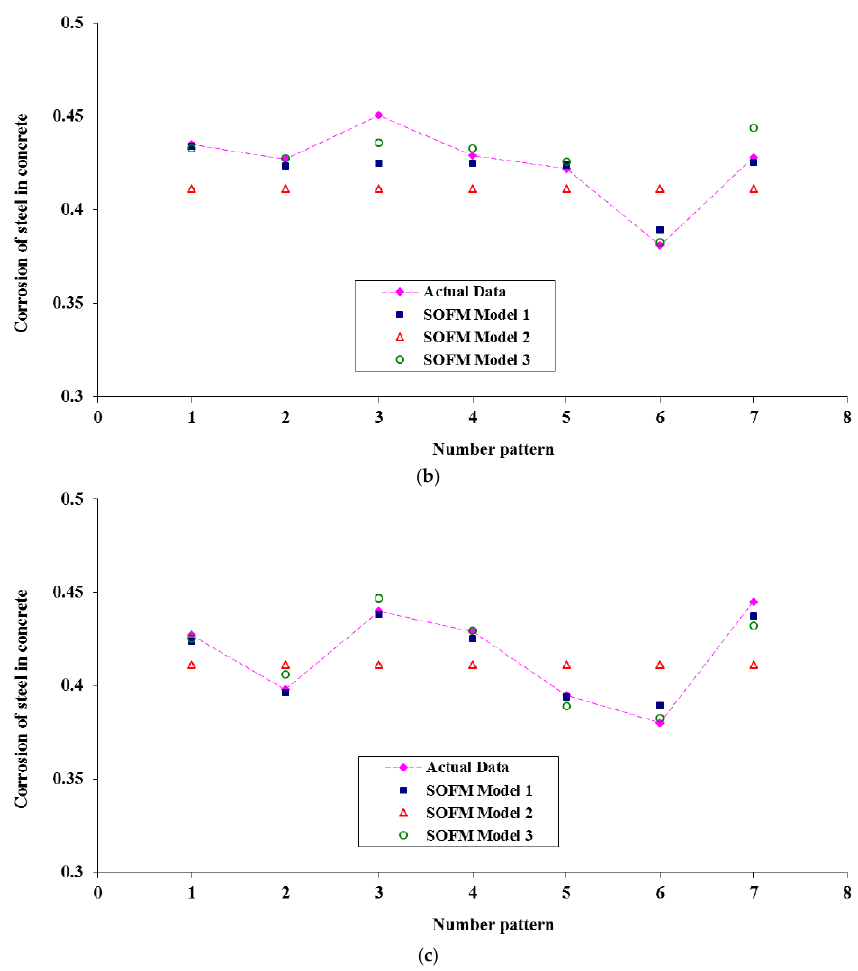
Figure 6. Comparison of corrosion current density prediction using the different SOFM models in the processes of ( a ) training, ( b ) validation, and ( c ) testing.